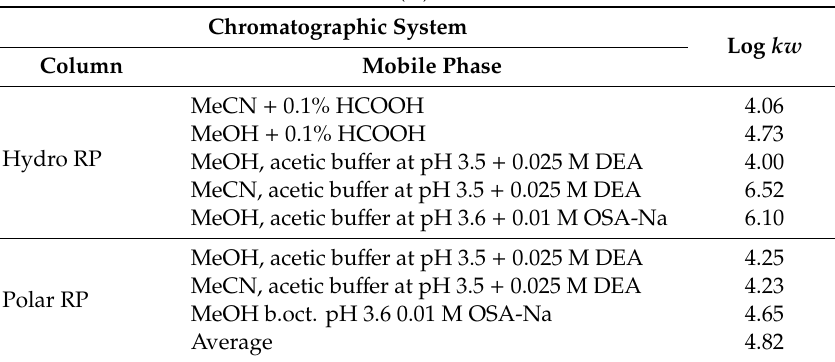
Table 2. ( A ). Values of log kw obtained in various chromatographic systems. ( B ) Values Log P calculated in di ff erent computer